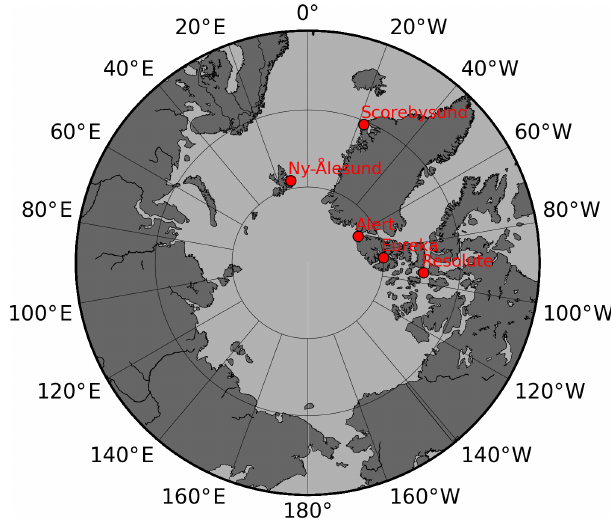
Figure 6. Location of the radiosonde and GPS